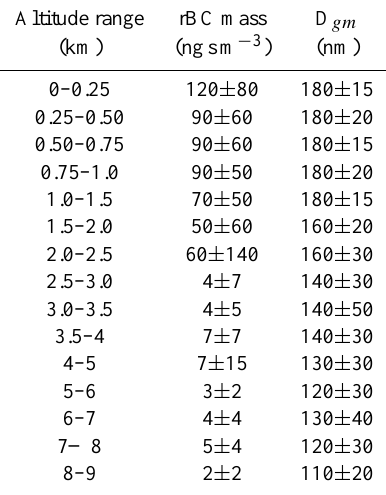
Table 3. Mean refractory black carbon (rBC) mass concentrations and mass geometric mean diameters ( ± 1 standard deviation) mea- sured by the SP2 aboard the FAAM aircraft and averaged over alti- tude bins for all